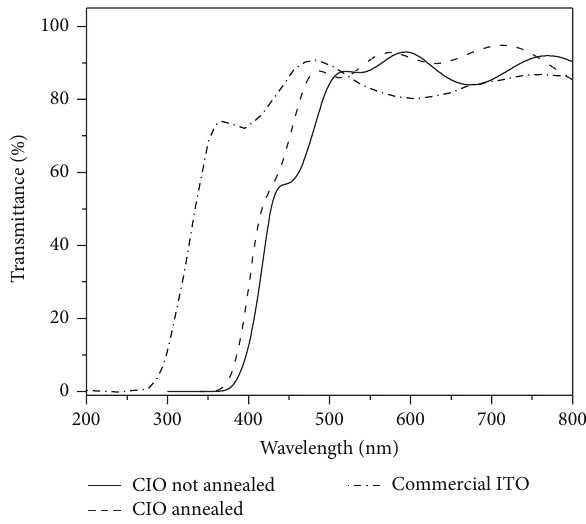
Figure 1: Optical transmittance spectra of a CdIn 2 O 4 film, only sintered (as grown) at 550 ∘ C (solid line) and after annealing during one hour in vacuum at 525 ∘ C (dashed line). Optical transmittance spectrum of a commercial ITO film (dash dot line).